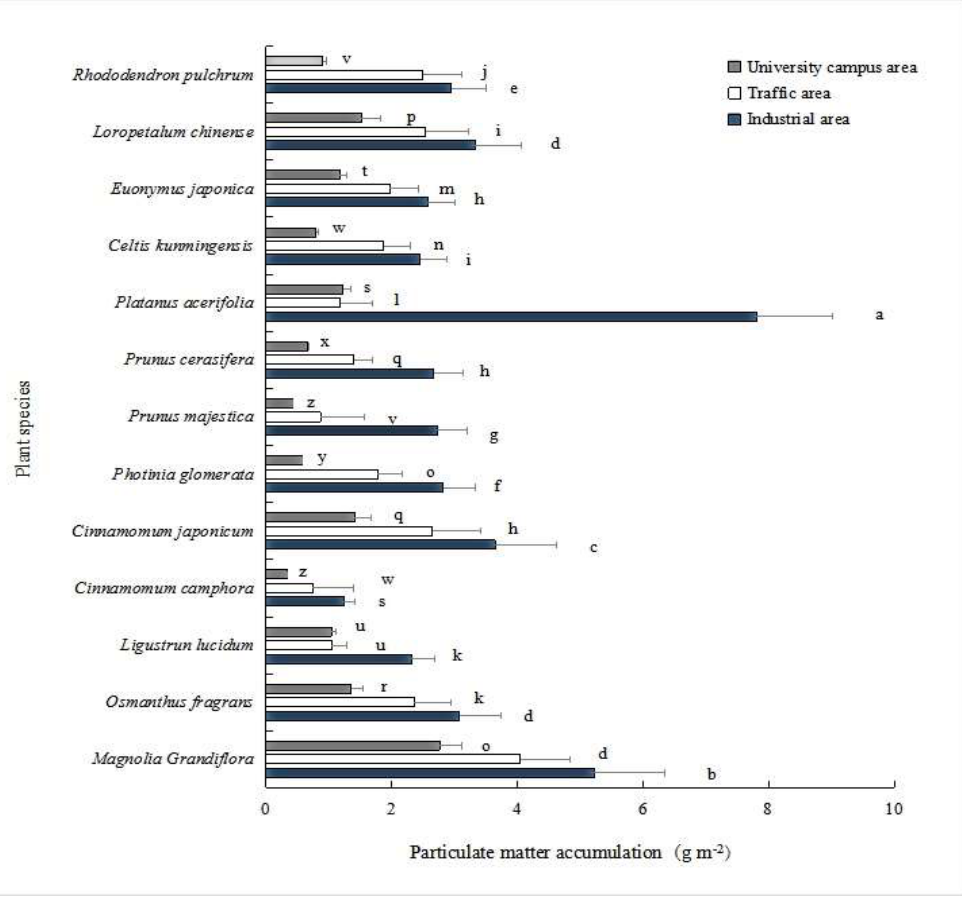
Figure 4. Accumulation of total particulate matter (means ± SE) on the leaves in the three clusters found in the three functional zones. Bars are means ± SE. Treatments with the same letter (a–h) were not significantly different (ANOVA with Duncan test, p < 0.05). SE is standard error.